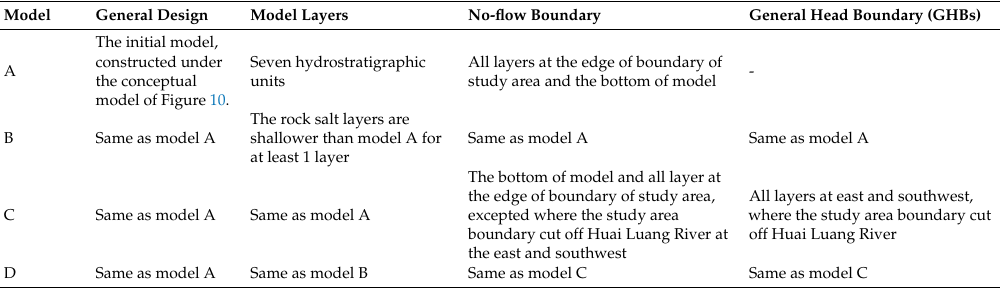
Table 2. Comparison of alternative conceptual models’